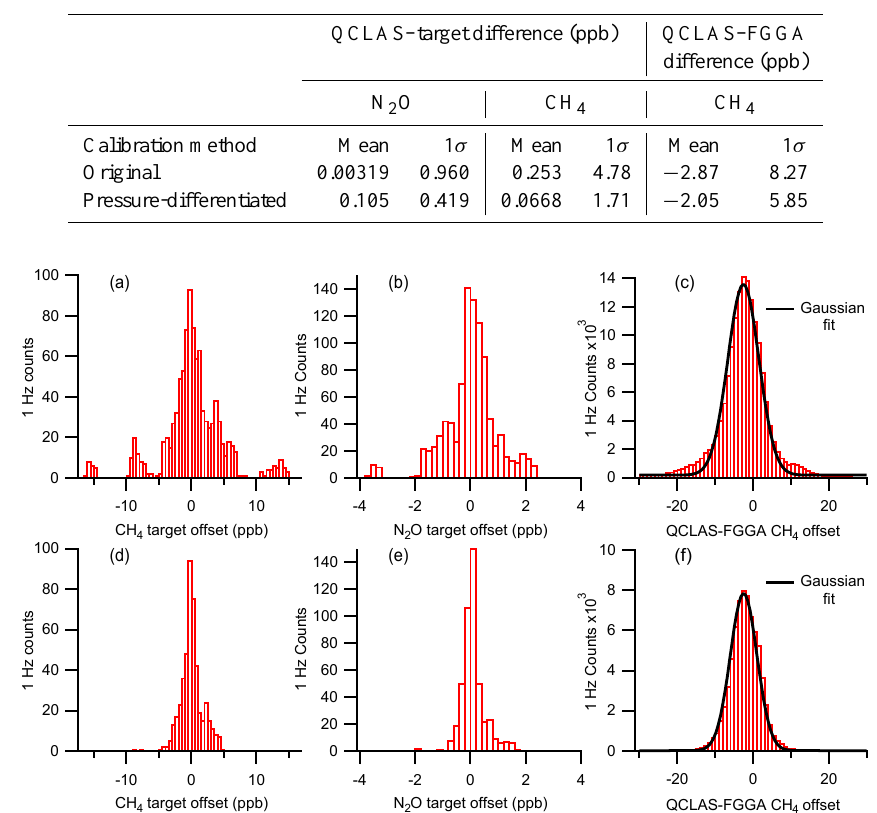
Table 1. Mean and standard deviation of the difference between QCLAS 1Hz target cylinder measurements and the nominal cylinder values and the difference between the 1Hz QCLAS and the corresponding 1Hz FGGA sample CH 4 measurements, using both the original and pressure-differentiated calibration methods.